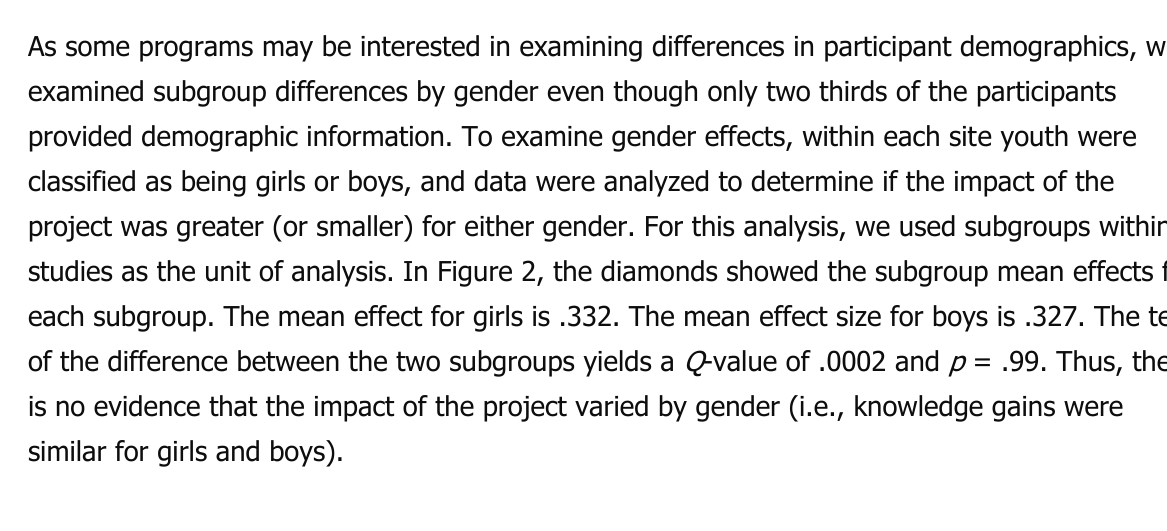
Figure 2. Subgroup Analysis